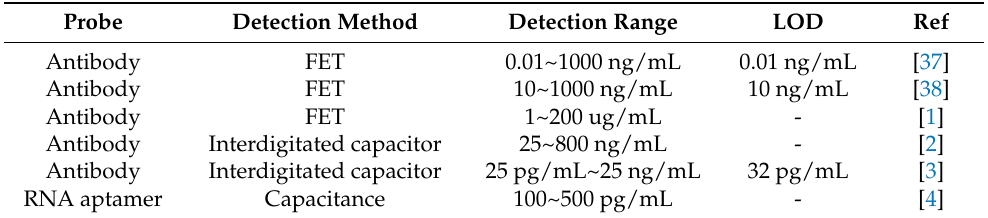
Table 1. The biosensing techniques using electrical means of detection techniques discussed in this